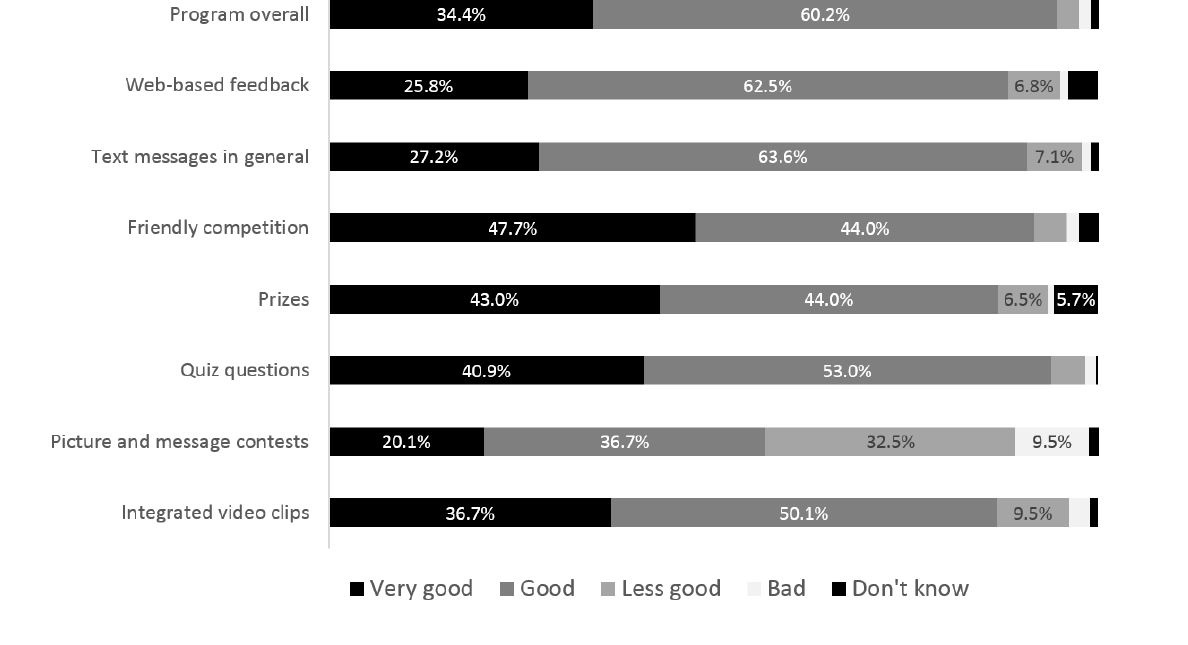
Table 2. Pre-post comparisons of variables addressing life skills.